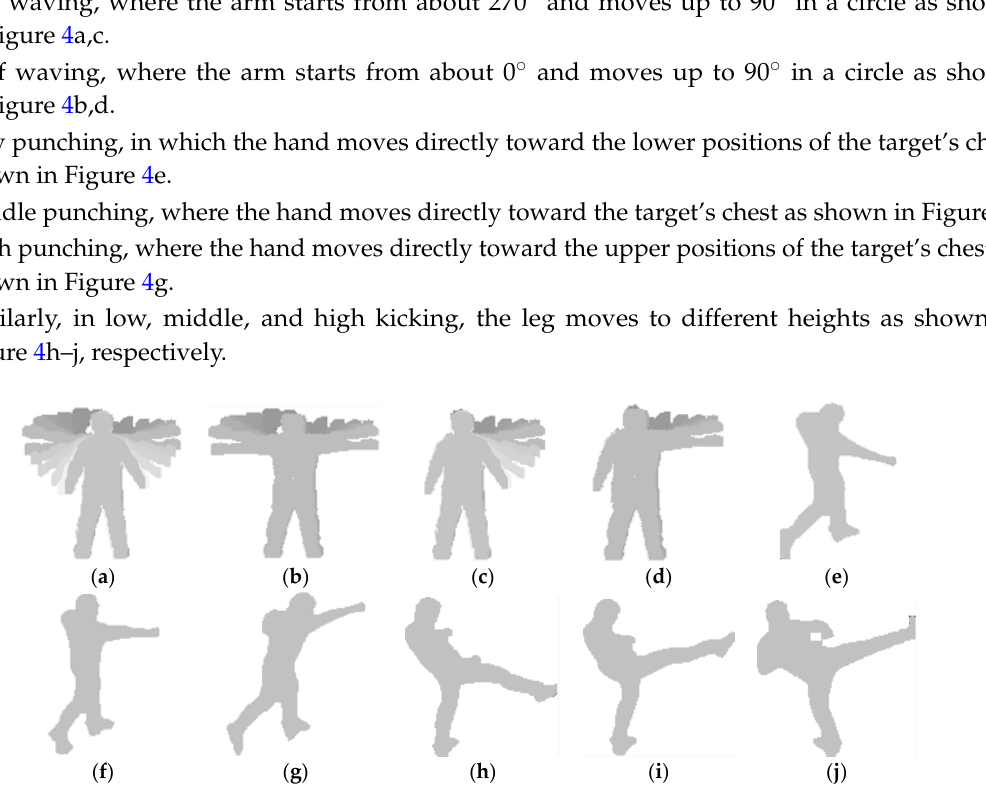
Figure 4. Comparison of motion patterns of each type of behavior. Waving: ( a ) full, by using two hands; ( b ) half, by using two hands; ( c ) full, by using one hand; ( d ) half, by using one hand. Punching: ( e ) low; ( f ) middle; ( g ) high. Kicking: ( h ) low; ( i ) middle; ( j )